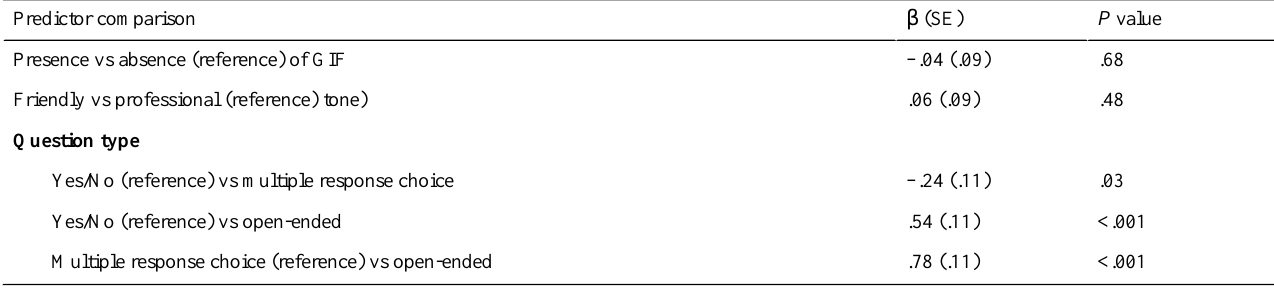
Table 2. Ordinal logistic regression for factors associated with likelihood of response